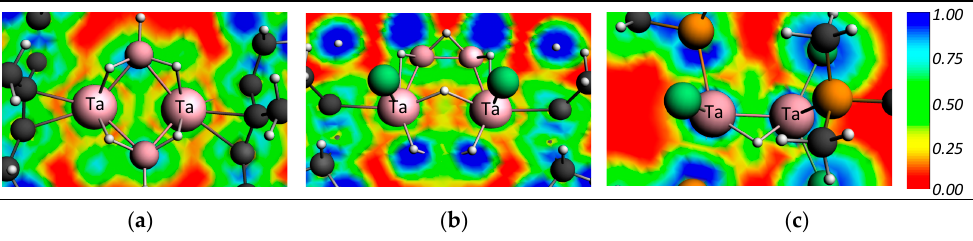
Figure 10. DFT ELF plots for clusters 6 (in the Ta-C(Cp)-Ta plane, ( a ), 23 (in the Ta-B-Ta plane, ( b ), and [Ta 2 (PMe 3 ) 4 Cl 4 (µ-H) 2 ] (in the Ta-Cl-Ta plane, ( c ). ELF values vary from 0 to 1, the upper limit corresponding to perfect electron-pair localization (important covalent character), whereas the reference value of 0.5 corresponds to a perfect delocalization (homogeneous electron gas). Reprinted and adapted with permission from Ref. [79]. Copyright (2012) American Chemical Society.